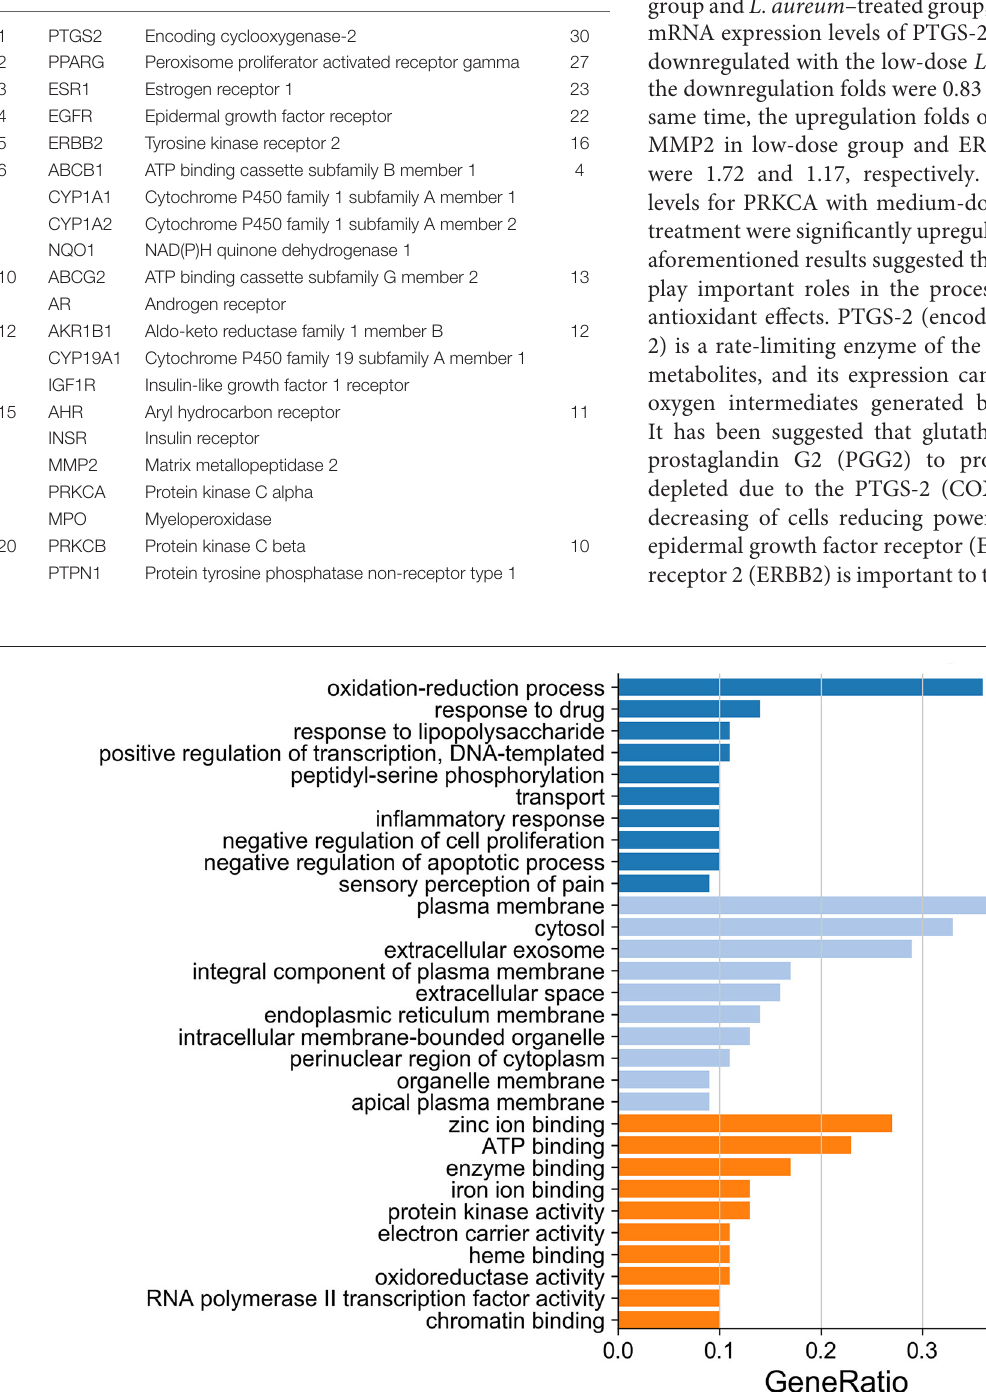
Frontiers in Veterinary Science |